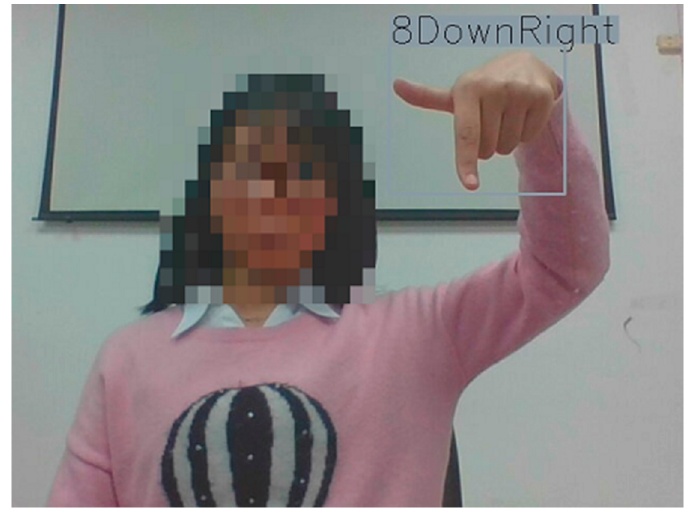
Figure 10. Result of recognition of hand postures in the conference room.